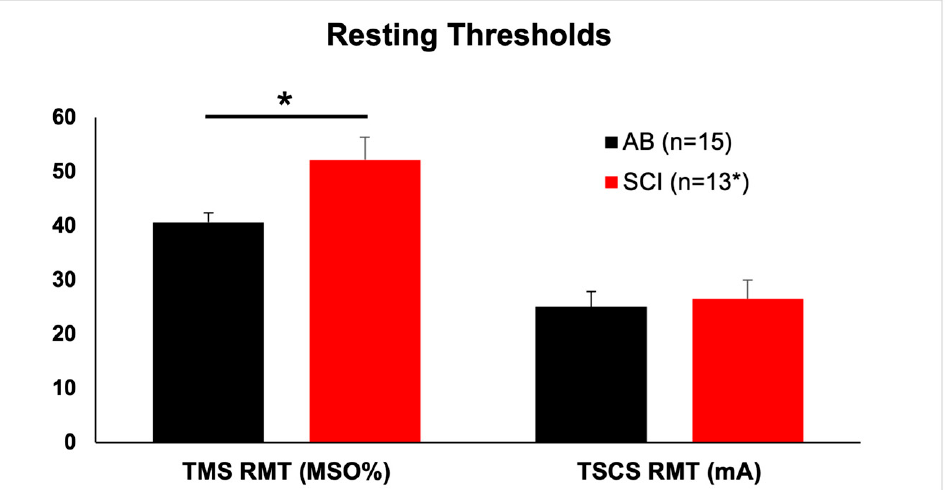
Figure 1. Resting thresholds are higher in SCI participants for TMS but not TSCS. Resting motor Figure 1 . Resting thresholds are higher in SCI participants for TMS but not TSCS . Resting motor threshold (RMT) for the abductor pollicis brevis (in two SCI participants, the first dorsal interosseous). Note that two SCI participants had unobtainable transcranial magnetic stimulation (TMS) responses, whereas all participants responded to transcutaneous spinal cord stimulation (TSCS). Hence, the asterisk next to “13” in the legend. MSO%, percent of maximal stimulator output. mA, milliamperes. Mean and SEM shown. *, p =